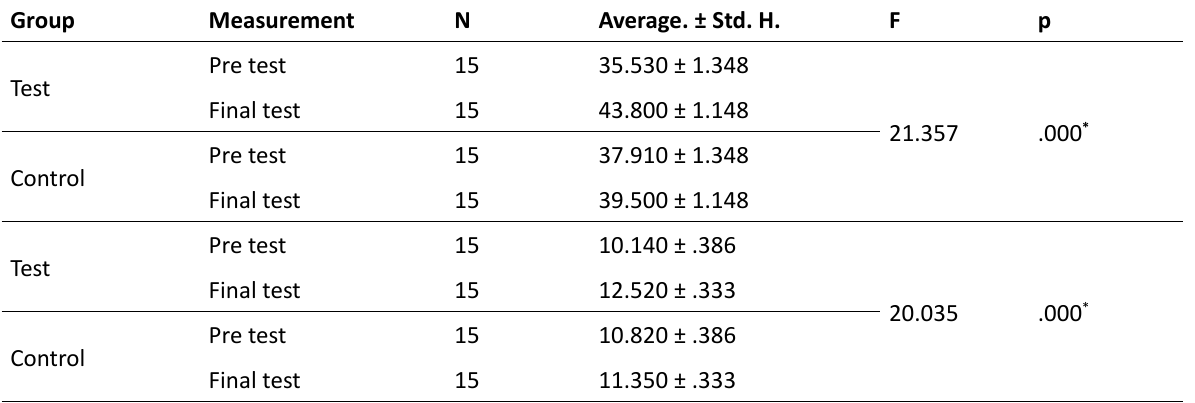
Table 4. VO Estimate Mg/kg/min and Met values group x time interaction 2Max